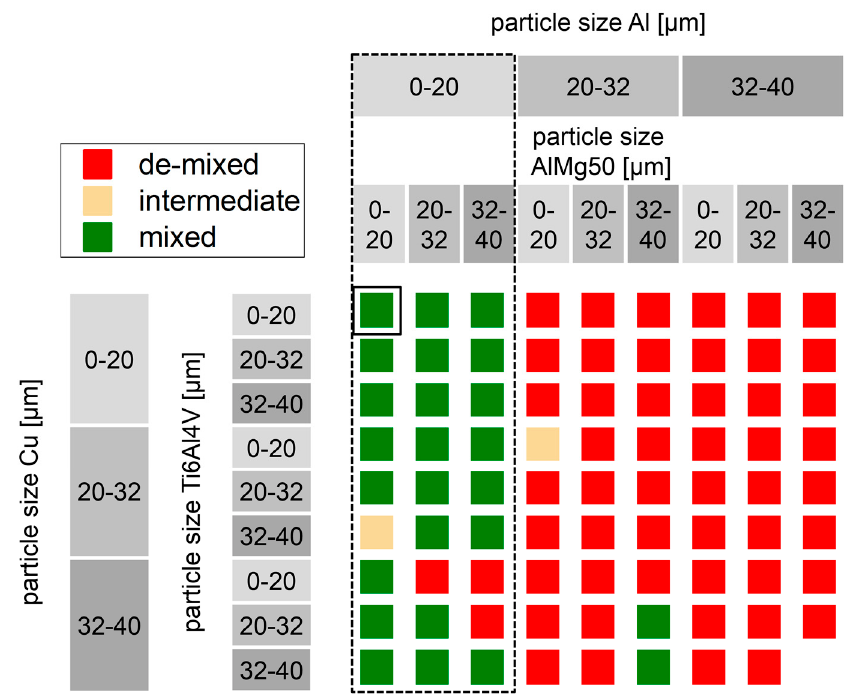
Figure 10. De-mixing of Al-Cu-Mg-Ti powder mixtures, under variation of particle size, obtained from vibrated test tubes, constant powder composition 92.4 wt% Al, 4 wt% Cu, 3 wt% AlMg50, 0.14 wt% Ti6Al4V, and 0.3 wt% SiO x ; dominating factor for stability is Al particle size < 20 µm.